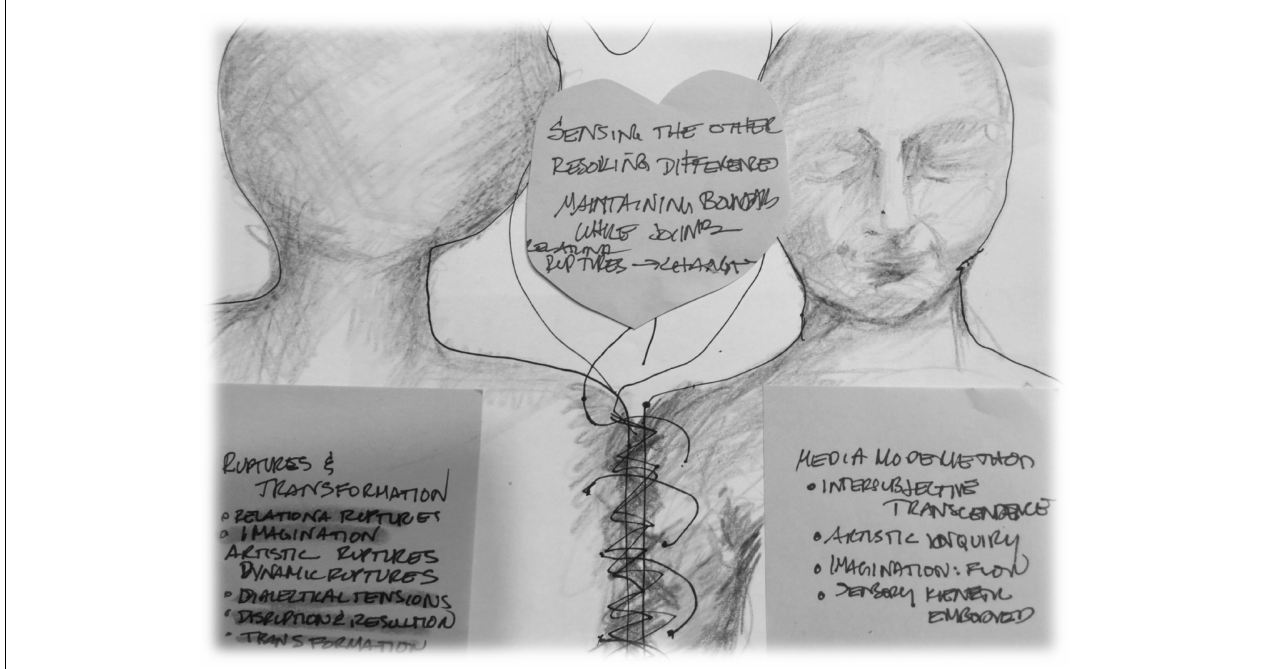
FIGURE 4 | Art-based thematic initial conceptualization—dialectical rupture and resolution. Original in color. Created by primary author.